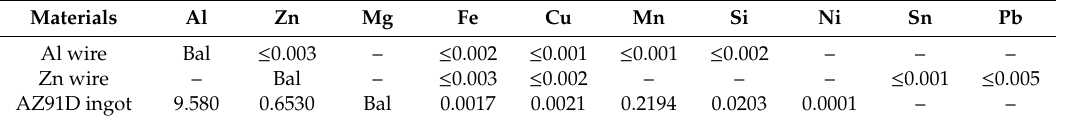
Table 1. Chemical compositions of Al wire, Zn wire, and AZ91D ingot (wt.%).